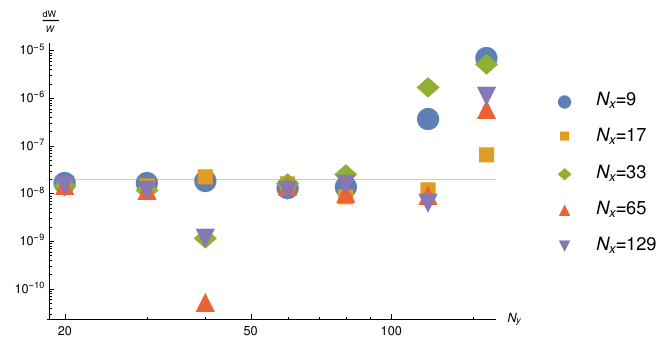
Figure 10 . Precision of the thermodynamic potential limited by the rounding errors for di(cid:11)erent Chebyshev grid